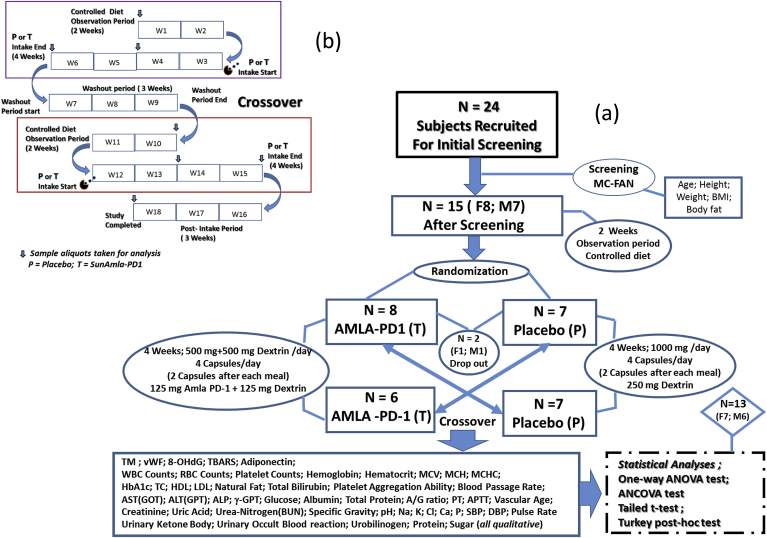
(a) Schematic presentation of the study protocol and procedures, and (b) Illustration of procedural details for evaluation of amla efficacies in randomized, double-blind, crossover placebo-controlled trial in healthy human subjects.